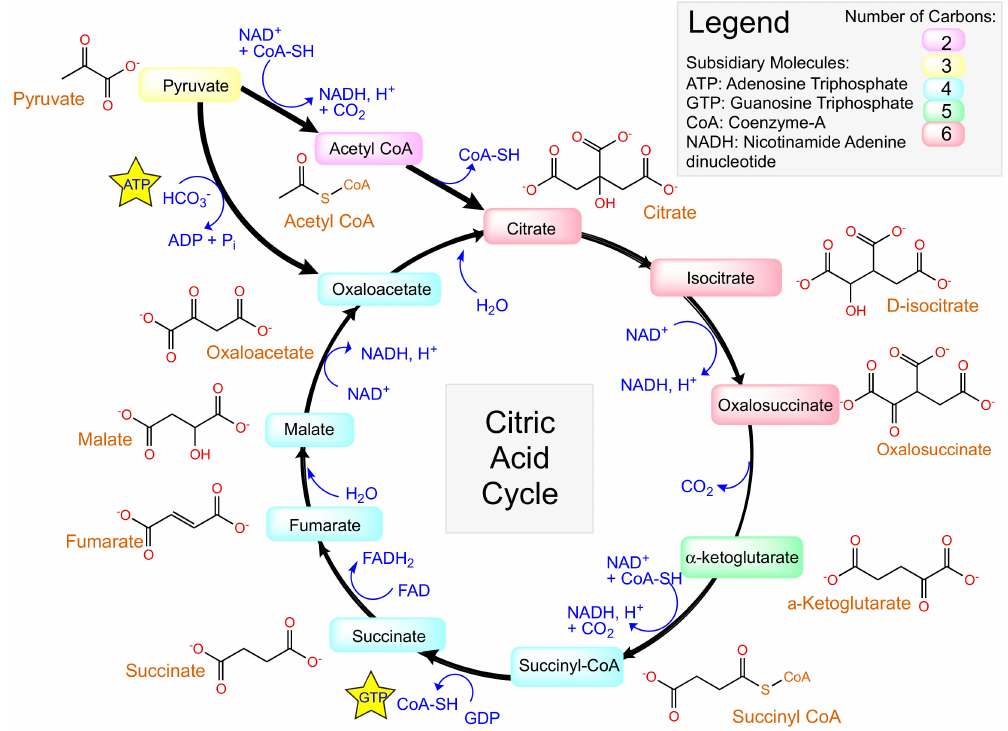
Figure 12. The Krebs cycle, or citric acid